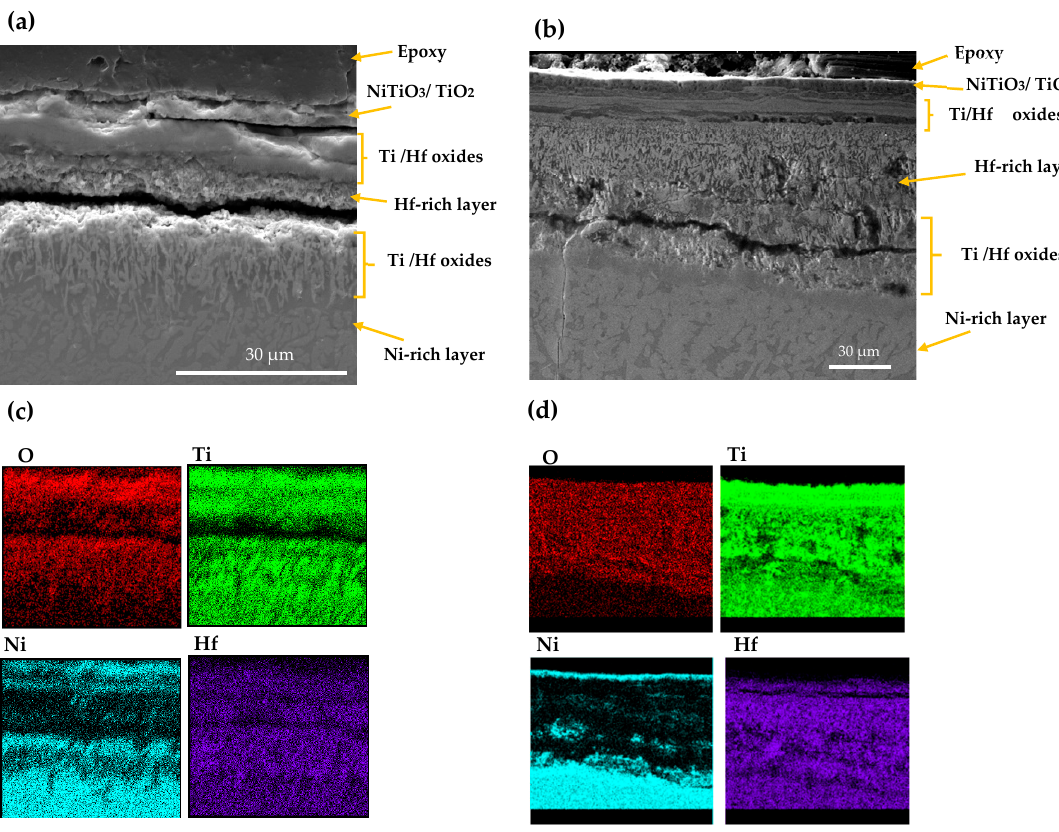
Figure 5. SEM image and X-ray mapping of the cross section of oxidation scale. ( a , c ) AM NiTiHf at 800 °C; ( b , d ) AM NiTiHf at 900 °C.